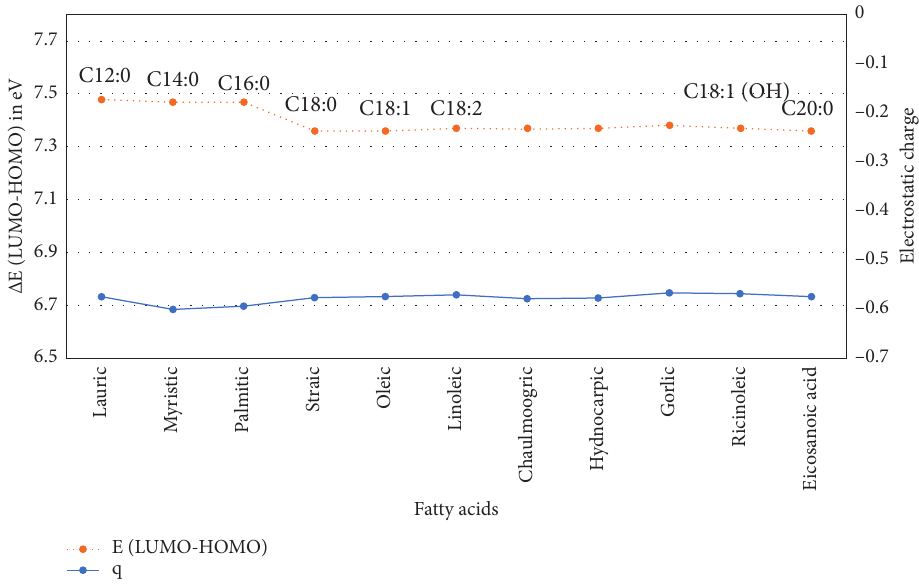
Figure 9: Electrostatic charge and orbital energy gap plotted against fatty acids. Table 2: Result of the tribological experiment. Vegetable oils Coefficient of